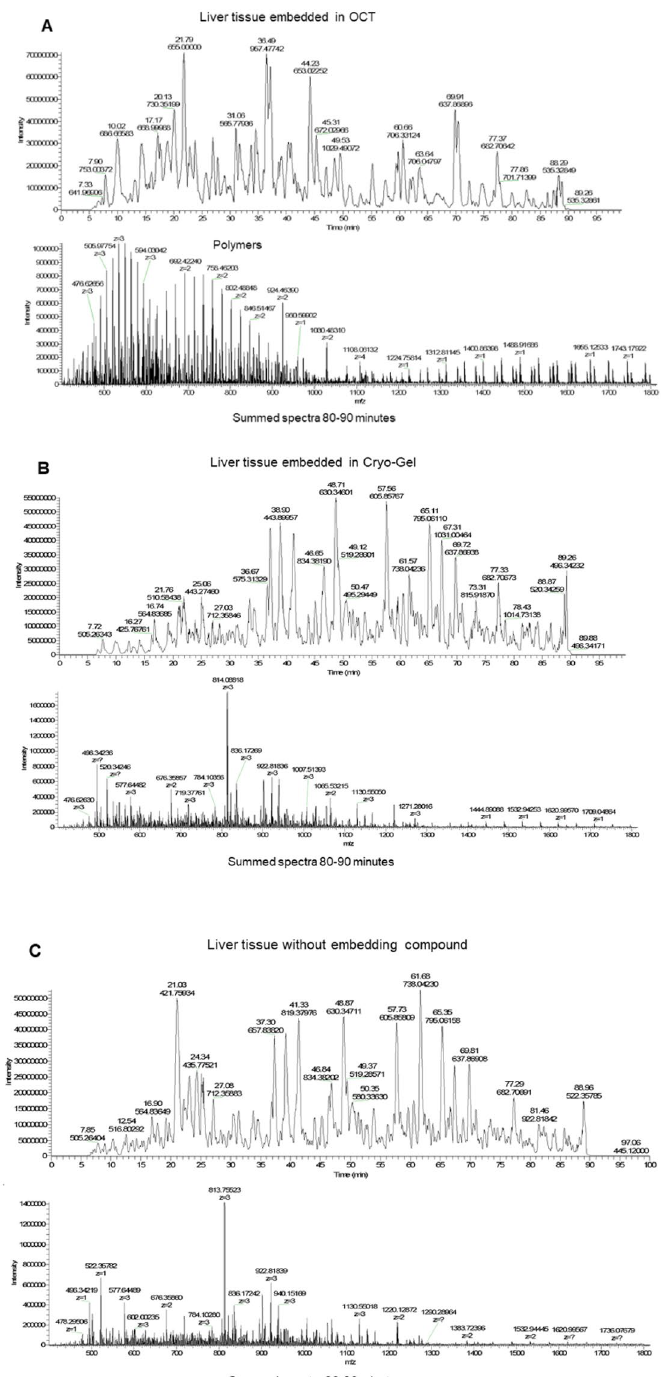
Figure 6. Mass spectra from liver samples embedded in OCT, Cryo-Gel and without compound. The summed spectra at 80–90 minutes show repeating polymer peaks in the OCT embedded samples disturbing the signal, but not in the samples embedded in Cryo-Gel and without